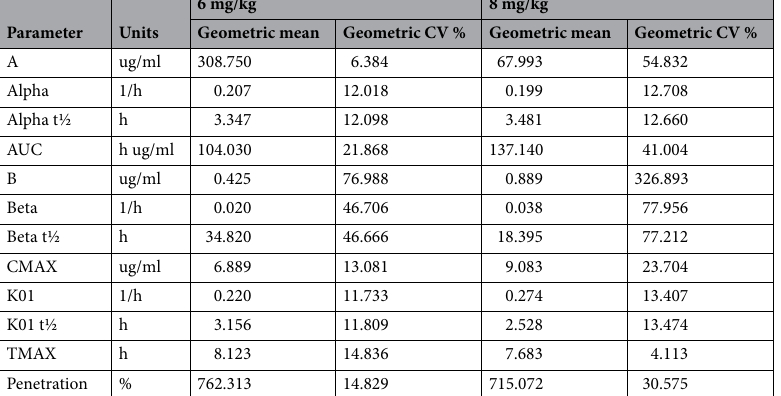
Table 3. Pharmacokinetic parameters for danofloxacin in ileum ultrafiltrate dosed at 6 mg/kg under the skin every 48 h for two doses and 8 mg/kg under the skin once. A, B, the intercept for the initial and terminal portions of the curve, respectively. Alpha (α) and beta (β) are the rate constants for the initial and terminal portions of the curves, with their respective half-lives (t½). K01 is the absorption rate and corresponding half- life (t½). C MAX maximum drug concentration, T MAX time to maximum drug concentration.